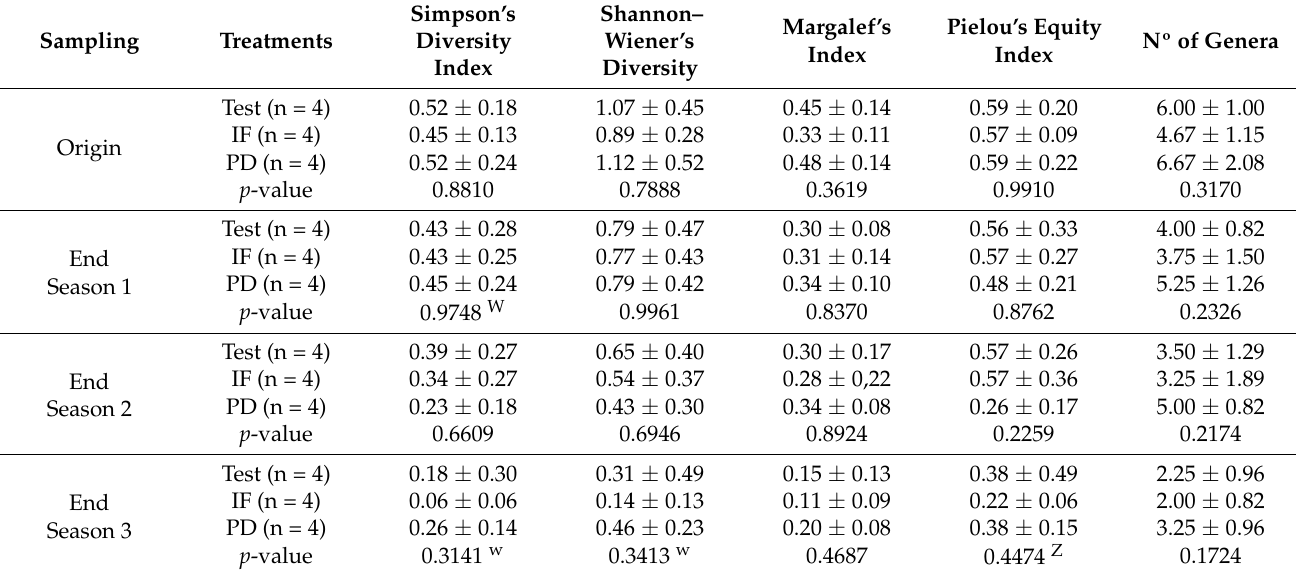
Table 3. Biodiversity indices of the fungal community in the three years of study (September–April cycles) as a function of crop nutrition. Values (mean ± standard